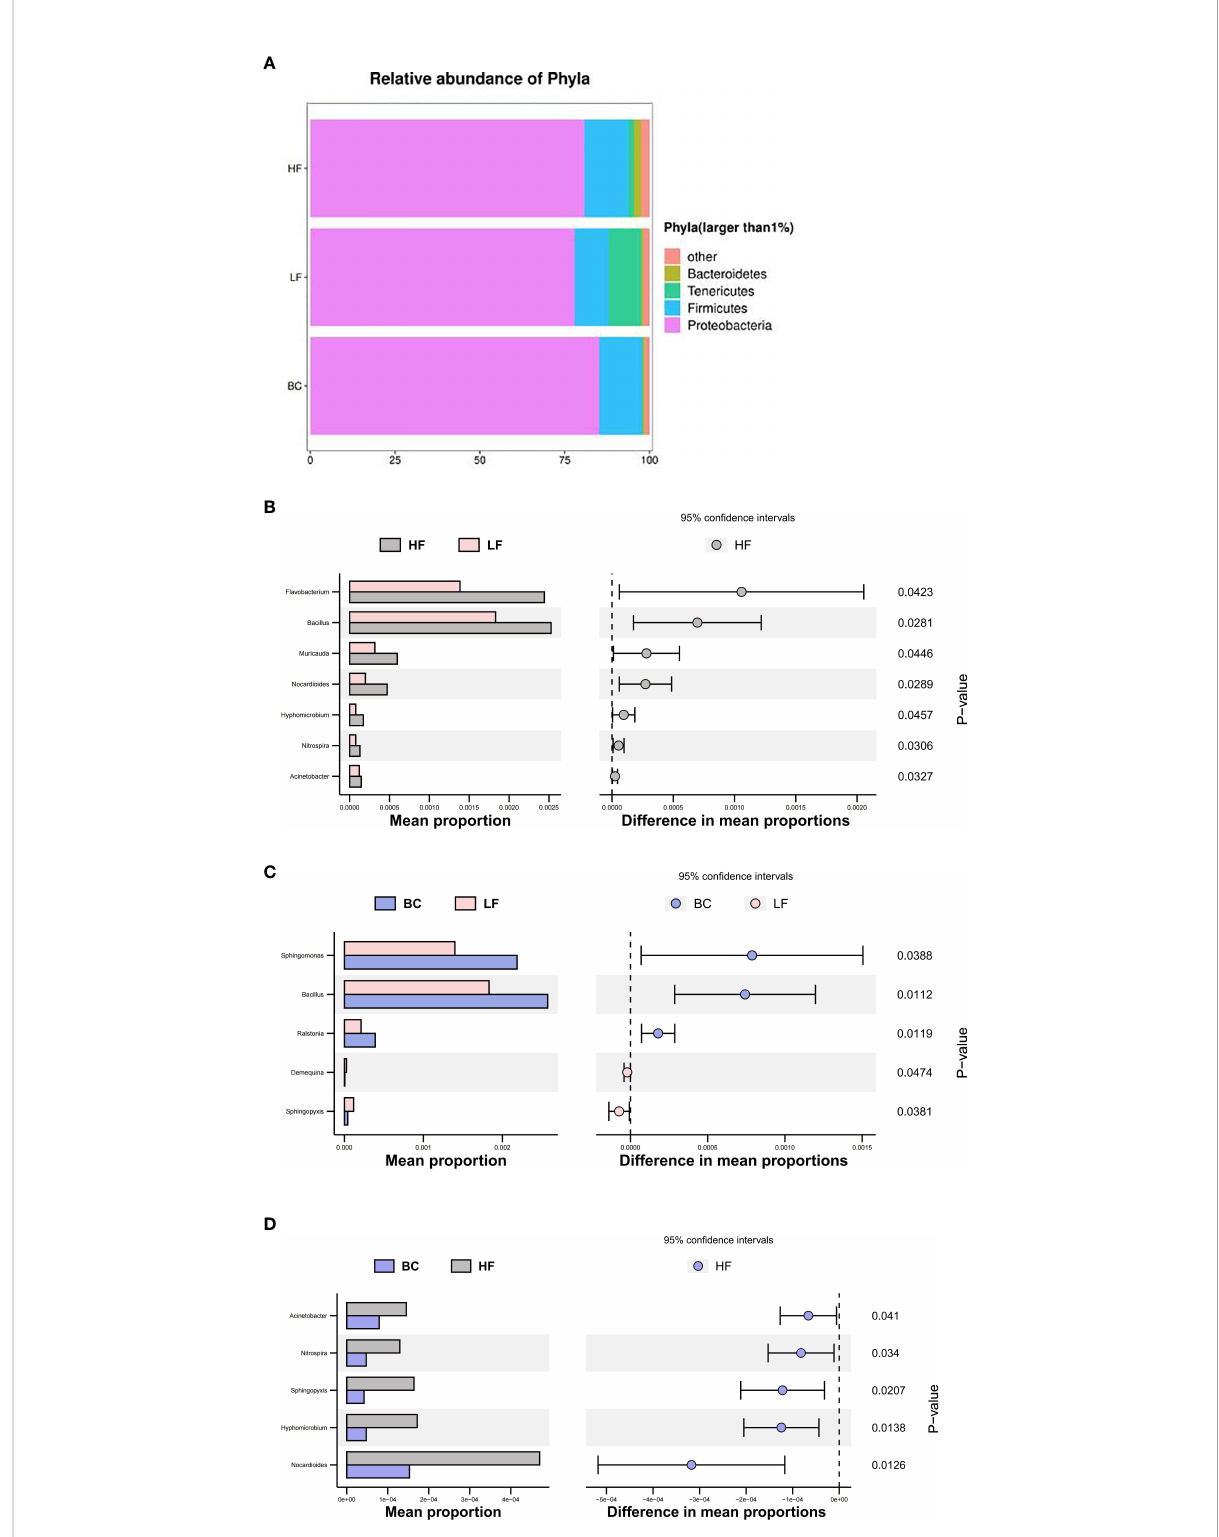
FIGURE 6 (A – D) Microbial community structure of Macrobrachium rosenbergii treated with different